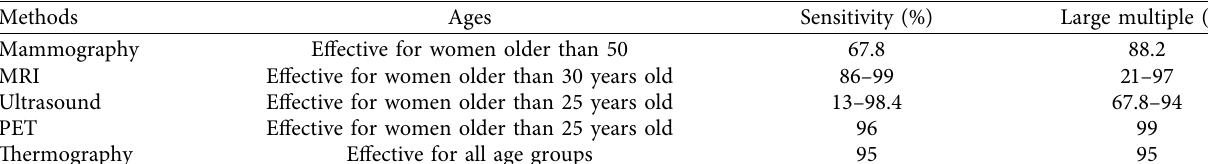
Table 1: Comparison between the diferent screening methods of breast cancer [12].